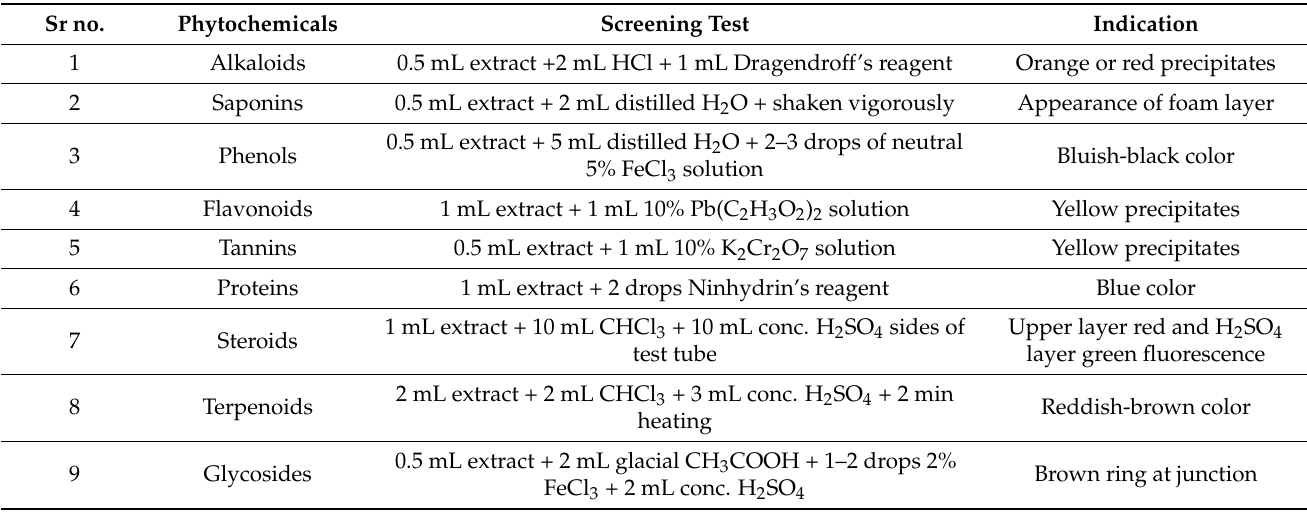
Table 1. Phytochemical screening tests and their